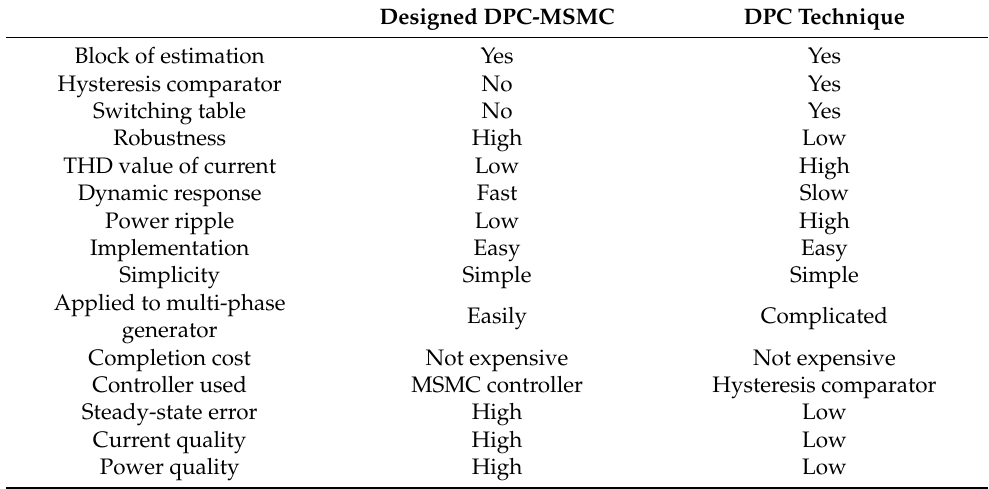
Table 3. Comparative study between the classical DPC strategy and the designed DPC-MSMC